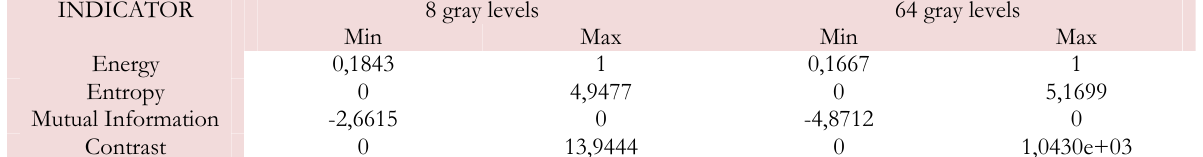
Figure 34: Mutual information 8 gray levels